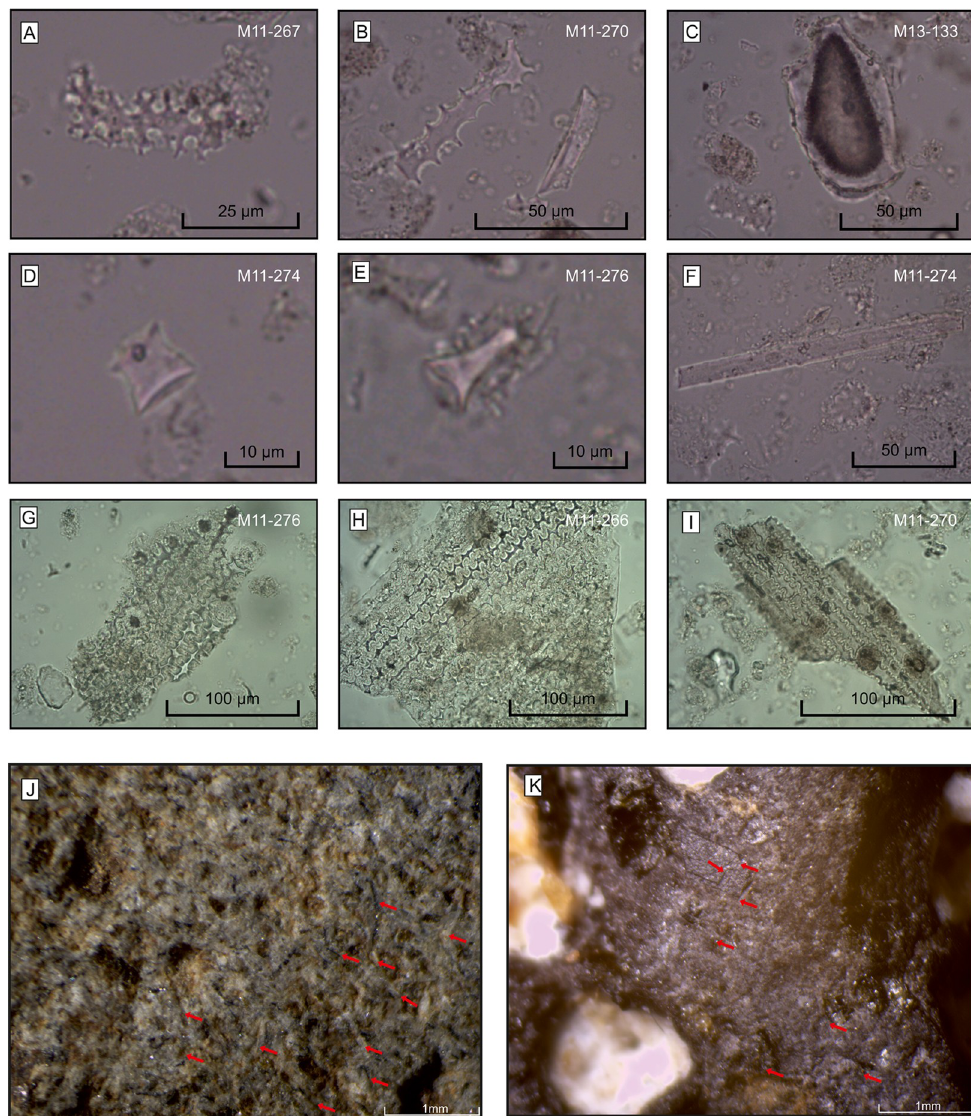
Fig 10. Go¨bekli Tepe. Microscopical analyses of phytoliths and use-wear. (A-I) Photomicrographs of phytoliths identified in the samples (400 x magnification). (A) elongate dendritic; (B) elongate echinate (left) and elongate trapeziform short cell (right); (C) bulliform cell; (D) rondel short cell; (E) tall rondel short cell; F: cilindroid psilate cell; (G-I) multicelled structures from inflorescence bracts (photos J. Meister). (J) Photomicrographs of use-wear from Neolithic handstones and (K) from experimental handstone replica used for processing einkorn (German Archaeological Institute, photos L. Dietrich).